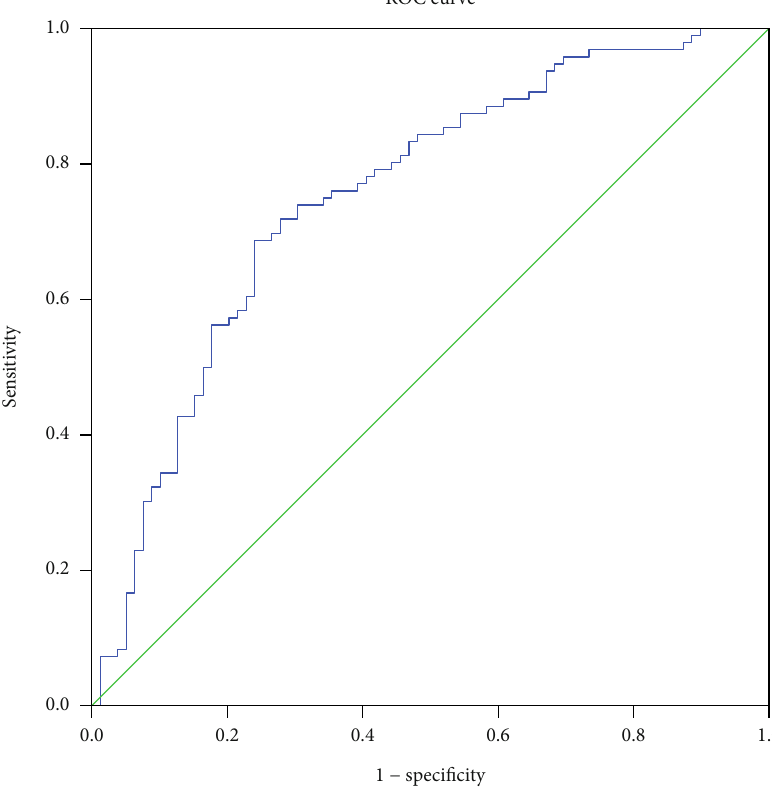
Figure 3: ROC curves for IDO in predicting